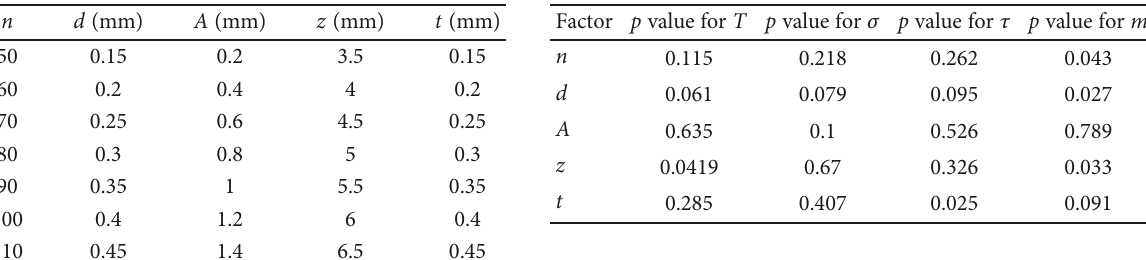
Table 7: Parameter-level table of the uniform test.